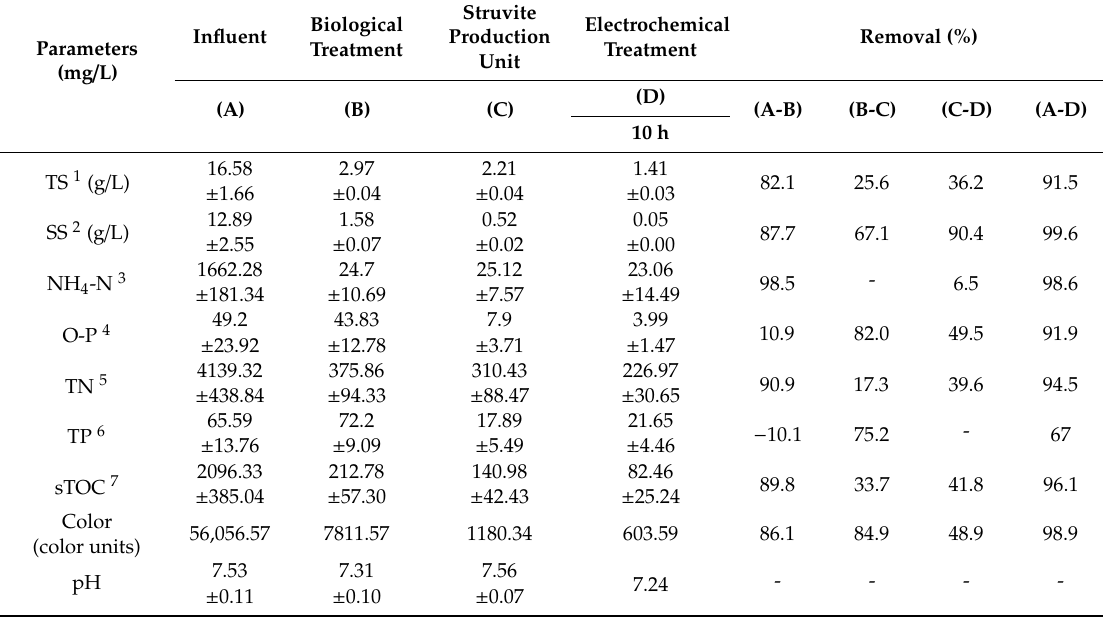
Table 4. Characteristics of e ffl uent according to unit processes in the